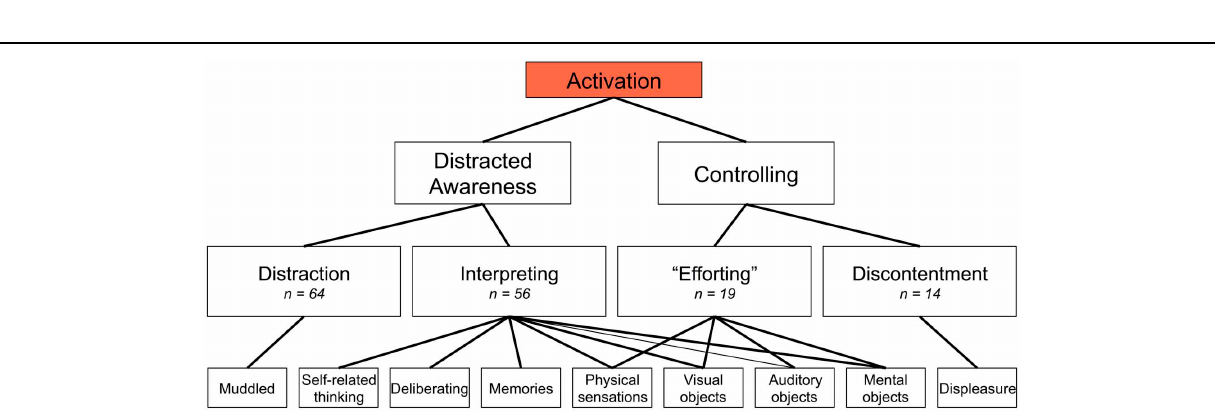
meditators reported instances of single-pointed concentration such as focus on the breath (i.e., concentration on the task) or open focus marked by a quality of clarity ( n = 99